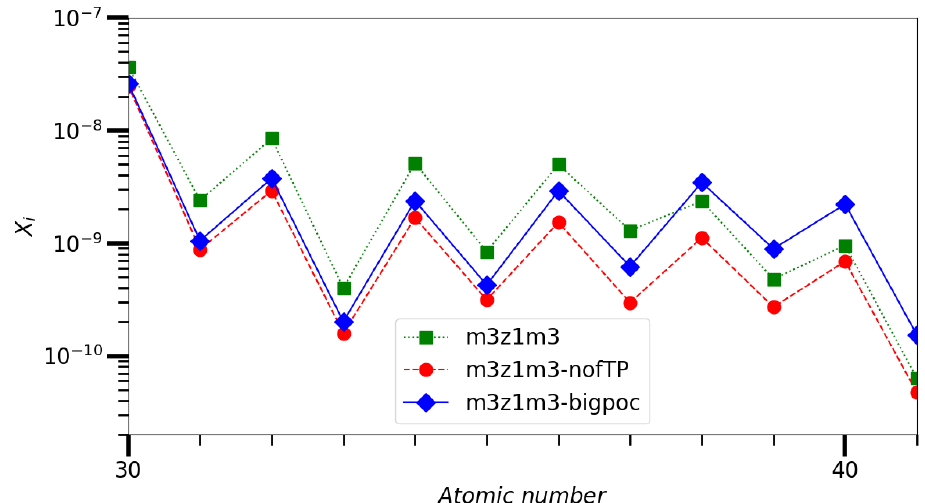
Figure 6. Heavy-element mass fractions of m3z1m3, m3z1m3-nofTP, and m3z1m3-bigpoc, zoomed in the 30 < A < 41 region. The [Rb/Sr] ratio is visibly higher in m3z1m3 compared to both m3z1m3- nofTP and m3z1m3-bigpoc.